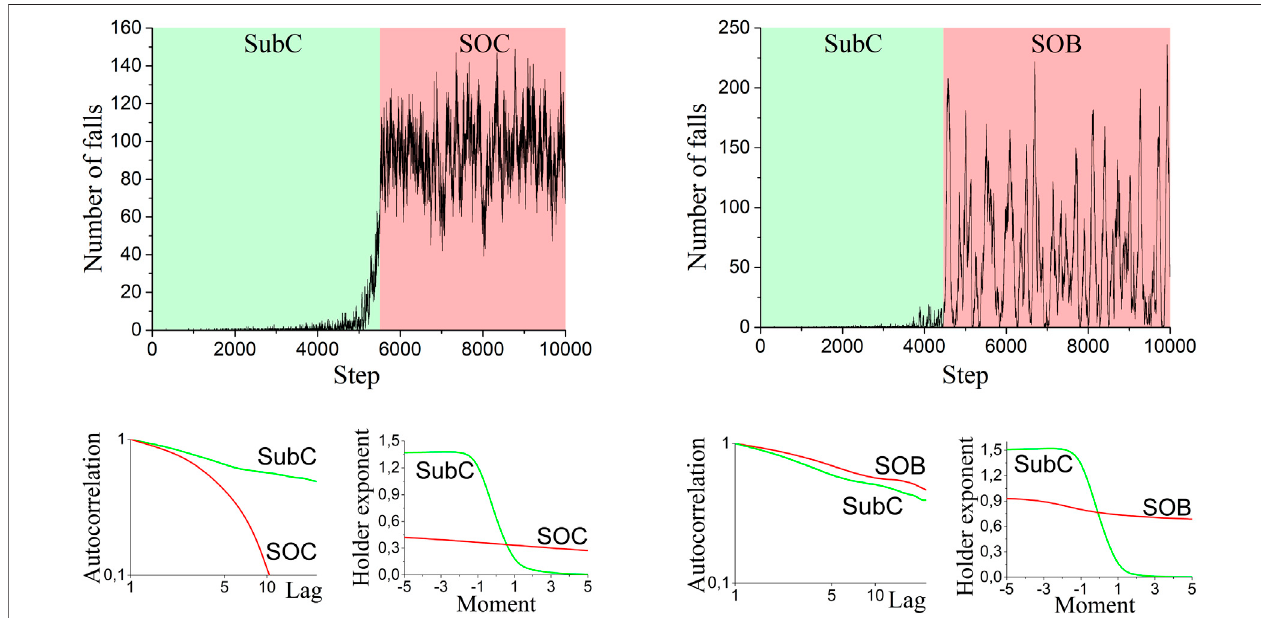
FIGURE1| Timeseriesoffallsforastandard (left) andfacilitated (right) BTWautomaton,andthecorrespondingautocorrelationfunctions(log-logplot)andHolder exponents.